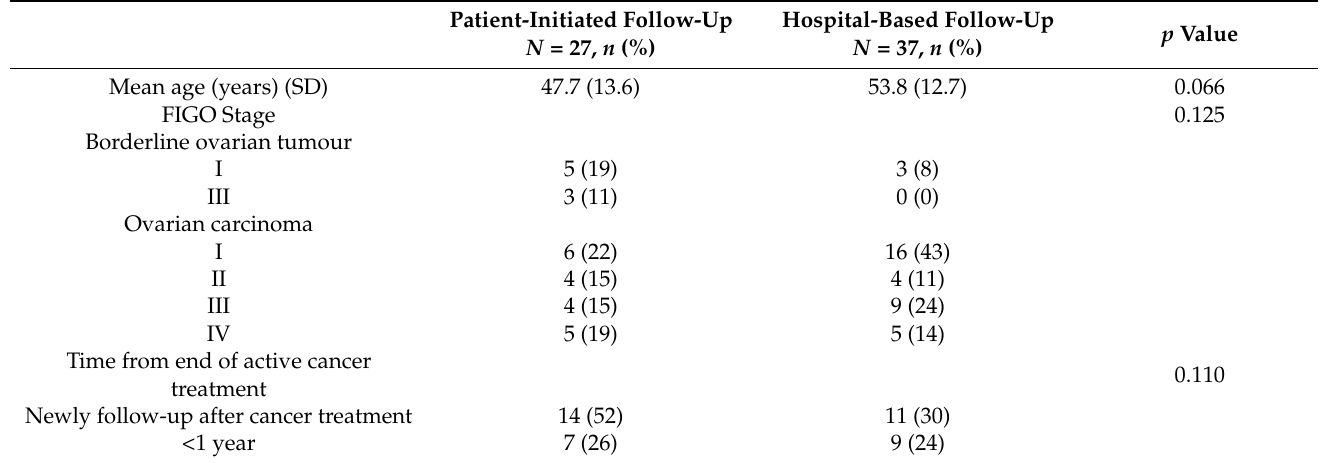
Table 1. Demographics of